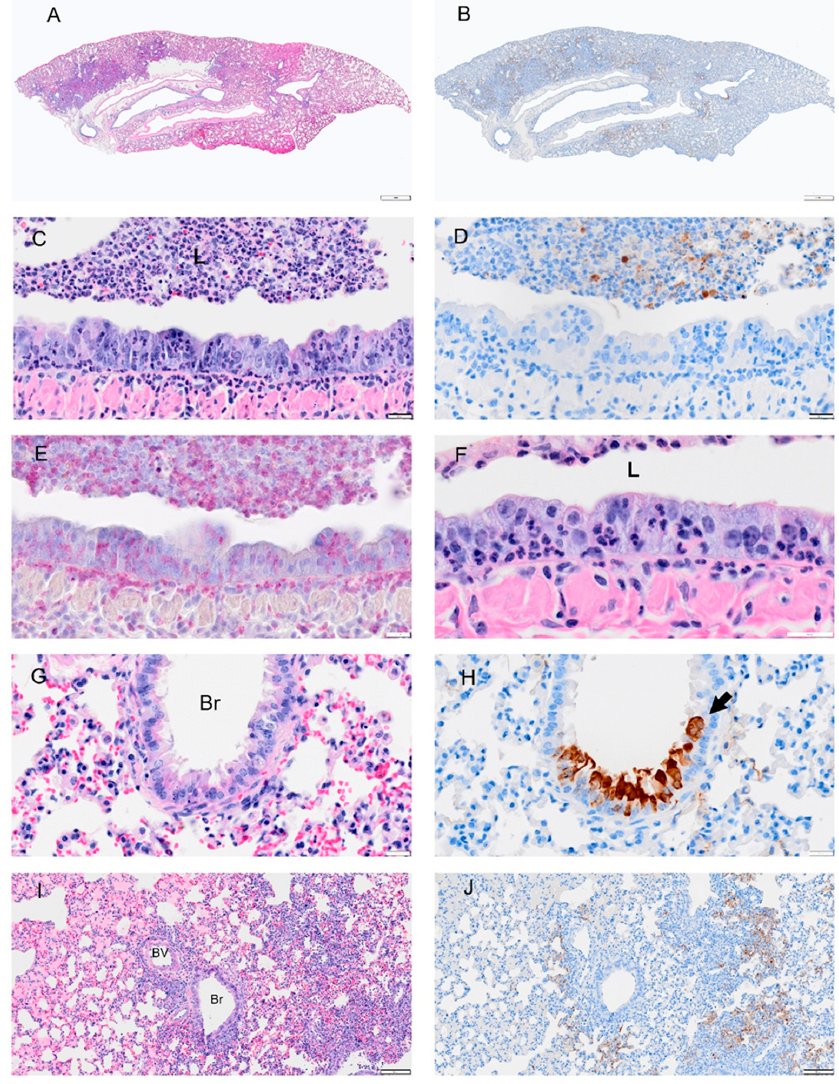
Figure 6. Selected pathology and immunohistochemistry of lungs from Syrian hamsters at 3 dpi with SARS-CoV-2. ( A ) Low magnification of a section with multifocal areas consolidation and hemorrhage. ( B ) An adjacent serial section of ( A ) shows viral antigen is concentrated at the margin of consolidated areas. ( C ) Higher magnification of bronchus shows debris with necrotic neutrophils, epithelial cells, and macrophages in bronchial lumen (L), abundant neutrophils within epithelial layer and submucosa, hyperplastic epithelial cells, and decreased cilia. ( D ) Adjacent serial section of ( C ) showing absence of viral antigen in the bronchial epithelium and but some remaining in luminal debris. ( E ) An adjacent serial section of ( C , D ) shows abundant neutrophils in the luminal debris, and within the epithelial and submucosal layers (visualized using NACE stain). ( F ) High magnification of the bronchial epithelium shows damaged mucosal epithelium with absent or very short cilia; neutrophils were the primary type of inflammatory cells. ( G ) H&E-stained section shows degenerated epithelial cells in small airways (Br). ( H ) An adjacent serial section to ( G ) shows viral antigen in damaged epithelial cells (arrow). ( I ) H&E-stained section shows hyperplasia of bronchiolar epithelium (Br), intra-alveolar inflammatory cell infiltrates (right side of image), and serous exudates filling alveolar spaces (left side of image). ( J ) Adjacent serial section of ( I ) shows viral antigen tends to be concentrated at the periphery of consolidated areas. Scale bars: ( A , B ) = 1 mm; ( C – H ) = 20 µ m; ( I , J ) = 100 µ